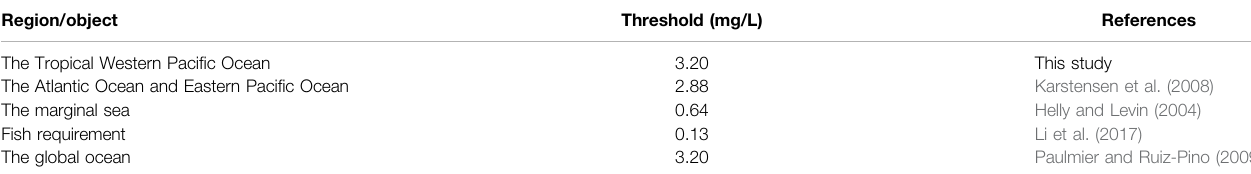
TABLE 1 | DO threshold of OMZ in different areas.